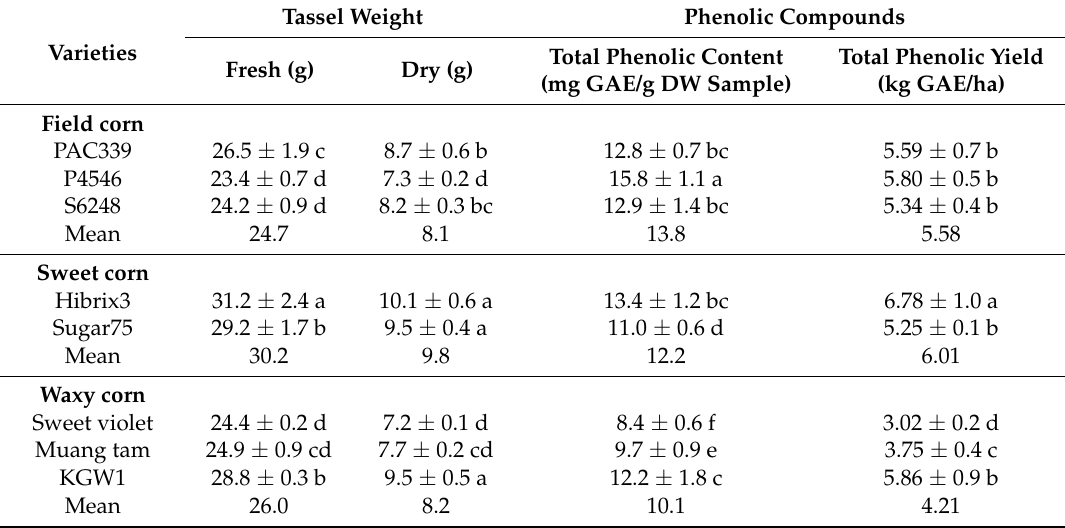
Table 3. Means for tassel fresh weight, tassel dry weight, total phenolic content, and total phenolic yield in the tassels of eight corn